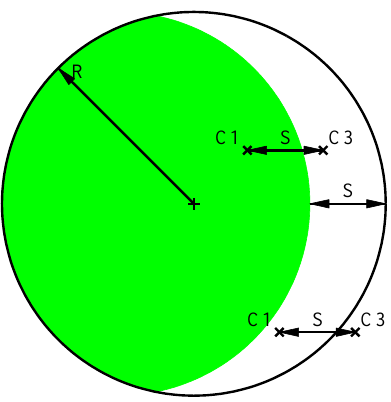
Figure 4. Illustration of the method by which the perpendicular Fig. 4. Illustration of the method by which the perpendicular plasmoid extent is estimated. The plasmoid is plasmoid extent is estimated. The plasmoid is shown by the large shown by the large black circle with radius R . If Cluster 1 is in the green area, Cluster 3 is also inside the plasmoid. If Cluster 1 is in the white crescent-shaped area, Cluster 3 is outside the plasmoid. The spacecraft black circle with radius R . If Cluster 1 is in the green area, Clus- positions,marked“ × ”,showexamplesofthetwosituations. ter 3 is also inside the plasmoid. If Cluster 1 is in the white crescent- shaped area, Cluster 3 is outside the plasmoid. The spacecraft posi- tions, marked “ × ”, show examples of the two